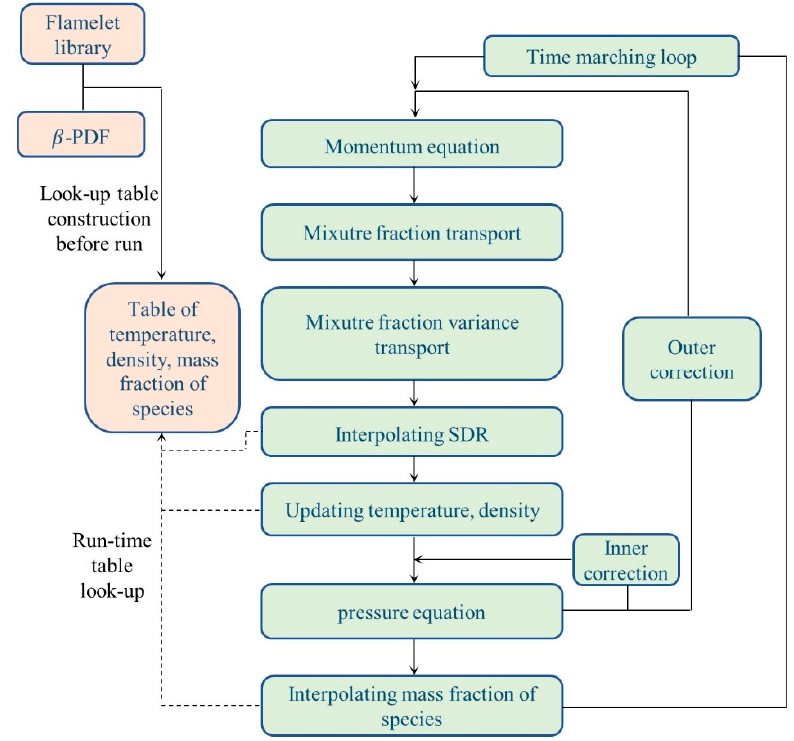
Figure 6. Flowchart of the SLFMFoam_LES solver algorithm. Solid lines indicate direction of calculation process; dotted lines indicate lookup process for flamelet table during calculation.